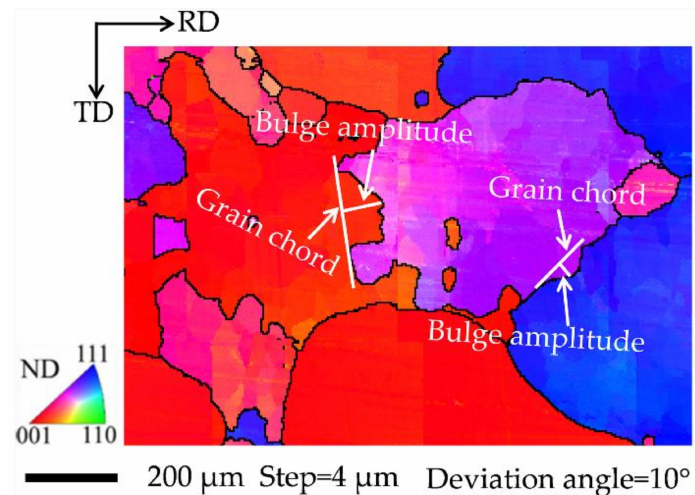
Figure 4. Local enlarged map of a region in Figure 3, indicating the definition of bulge amplitude. Table 1. Grain boundary type for four initial textures under two hot deformation conditions in Fe-3.0 wt.% Si